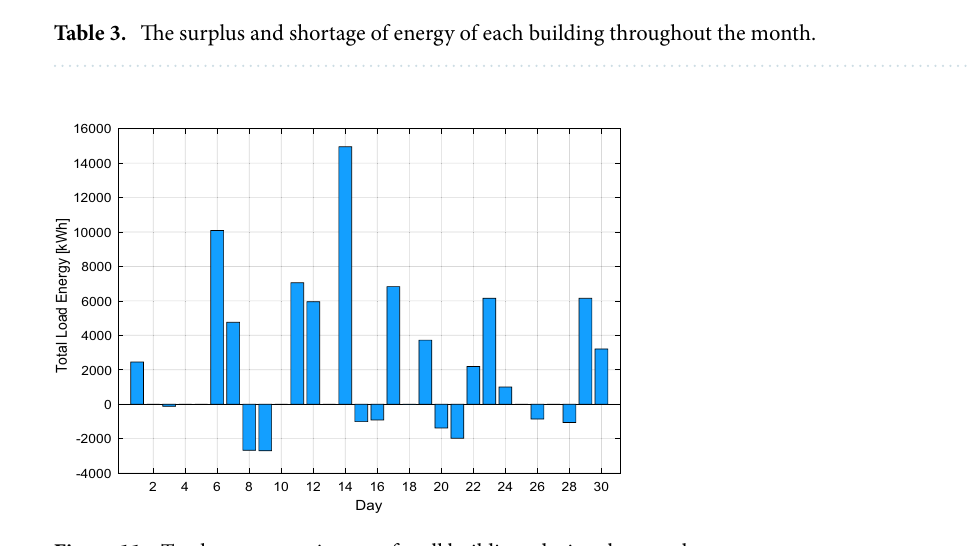
Figure 11. Total energy requirement for all buildings during the